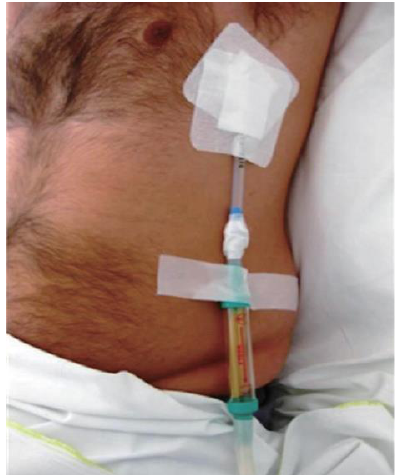
Figure 4. On the left chest, a Heimlich valve is connected to a chest tube